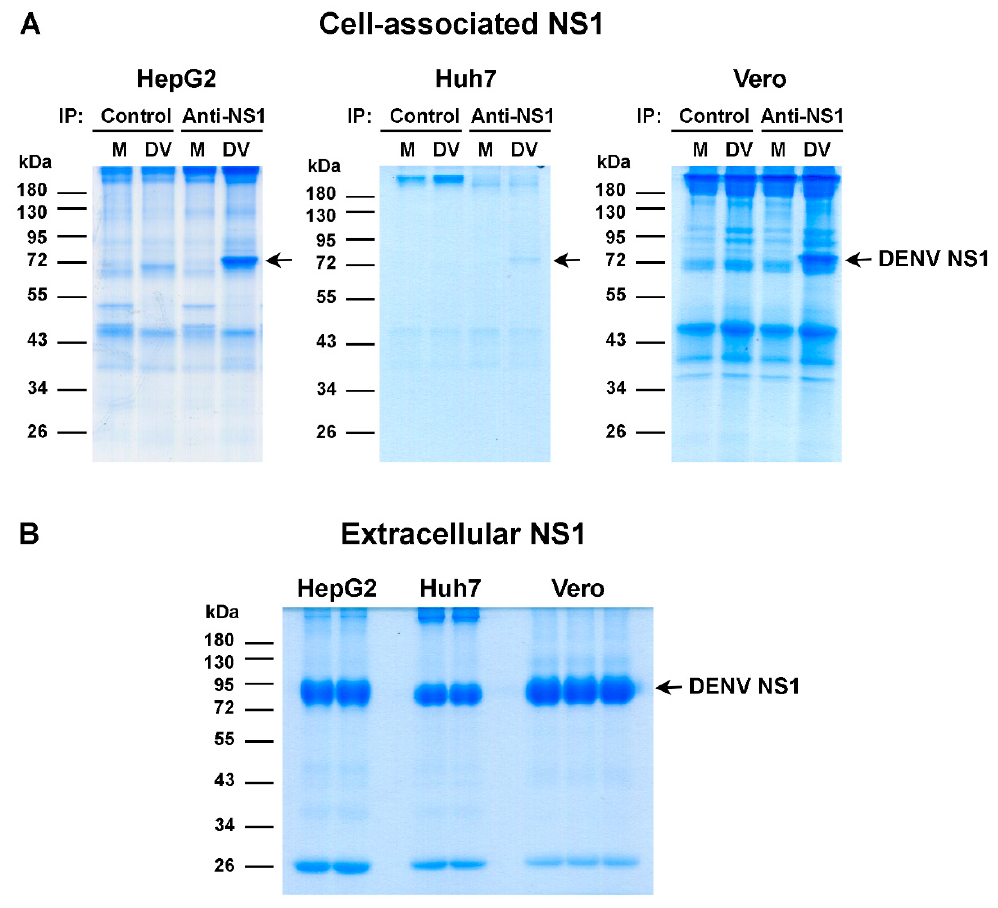
Figure 1. Preparation of cell-associated and extracellular NS1 proteins for LC-MS/MS analysis. HepG2, Huh7, and Vero cells were infected with DENV (DV) or left uninfected (mock, M). Cell lysates were harvested at day 2 post-infection and processed for immunoprecipitation with anti-NS1 antibodies (anti-NS1) or isotype-matched control antibodies (control). Culture supernatants were collected at day 2 (HepG2 and Huh7) or day 8 (Vero) post-infection and subjected to affinity chromatography to purify extracellular DENV NS1 using Sepharose 4B beads covalently linked with an anti-NS1 monoclonal antibody. Cell-associated NS1 proteins ( A ) and extracellular NS1 proteins ( B ) were analyzed by SDS-PAGE under non-heated and non-reduced conditions and Coomassie Brilliant Blue staining. Results show representative images of the stained gels. DENV NS1 protein bands (arrows; total approximately 20–25 µg) were excised from the gels and further processed for LC-MS/MS analysis of NS1 phosphopeptides.